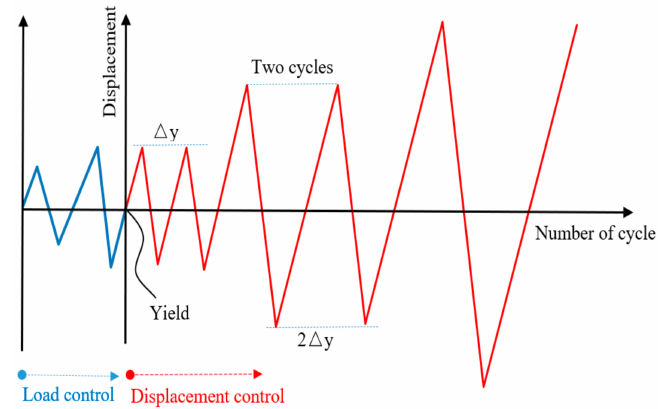
Figure 4. Loading